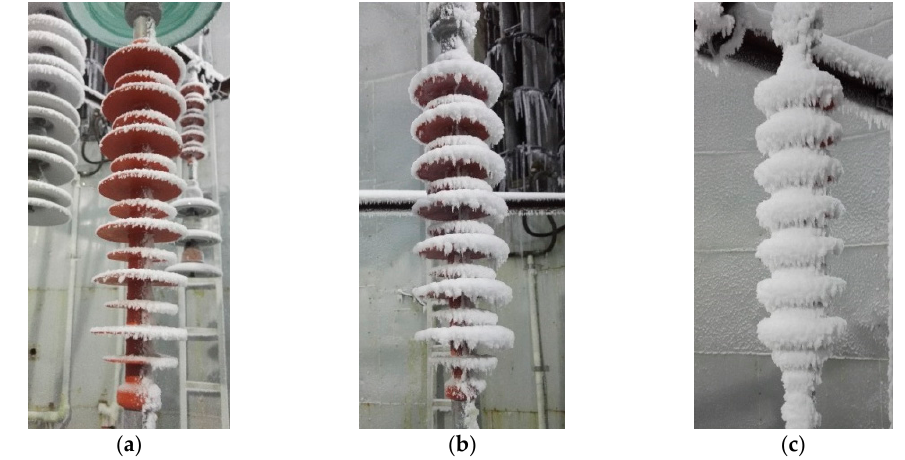
Figure 5. Appearance of snow-covered insulators in the artificial climate chamber. ( a ) d = 5 mm; ( b ) d = 10 mm; ( c ) d = 20 mm.